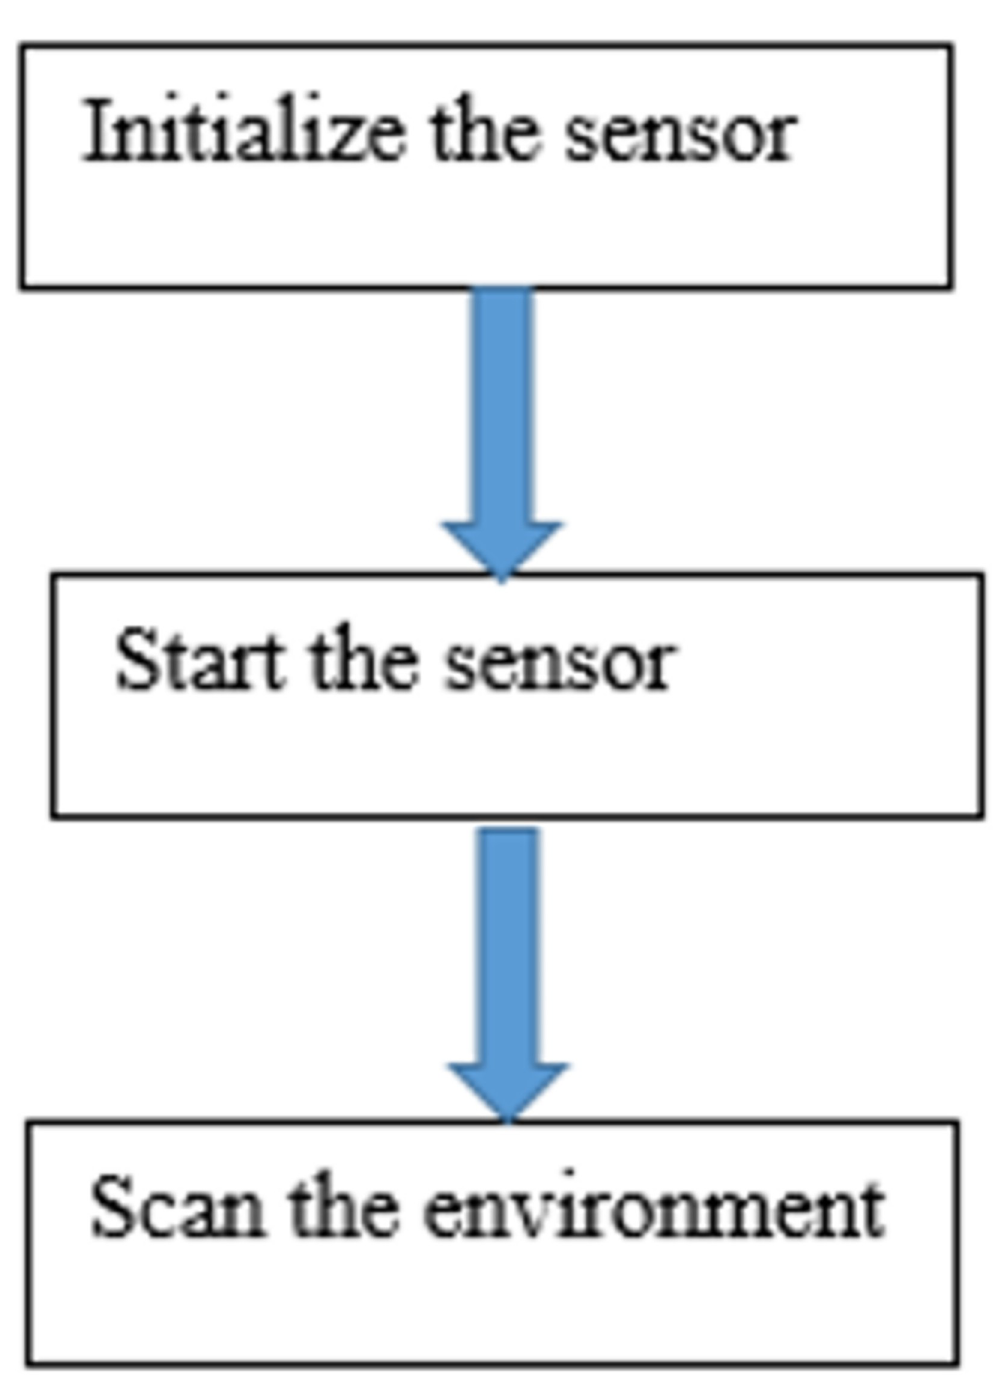
Fig 18. The sensor